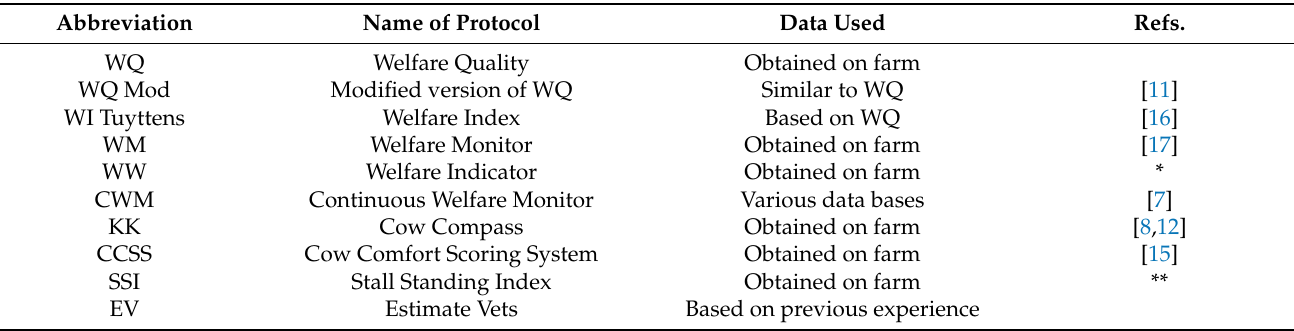
Table 1. The welfare assessment systems used in this